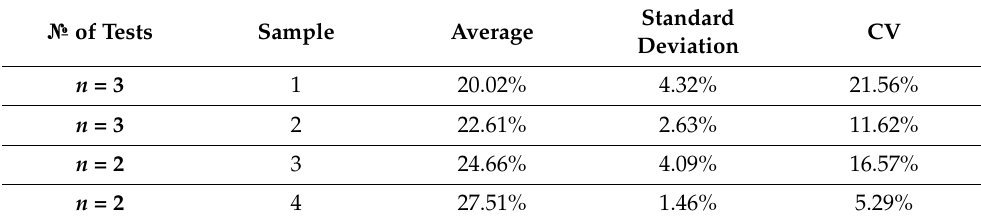
Table 5. Results for 0.50 g.